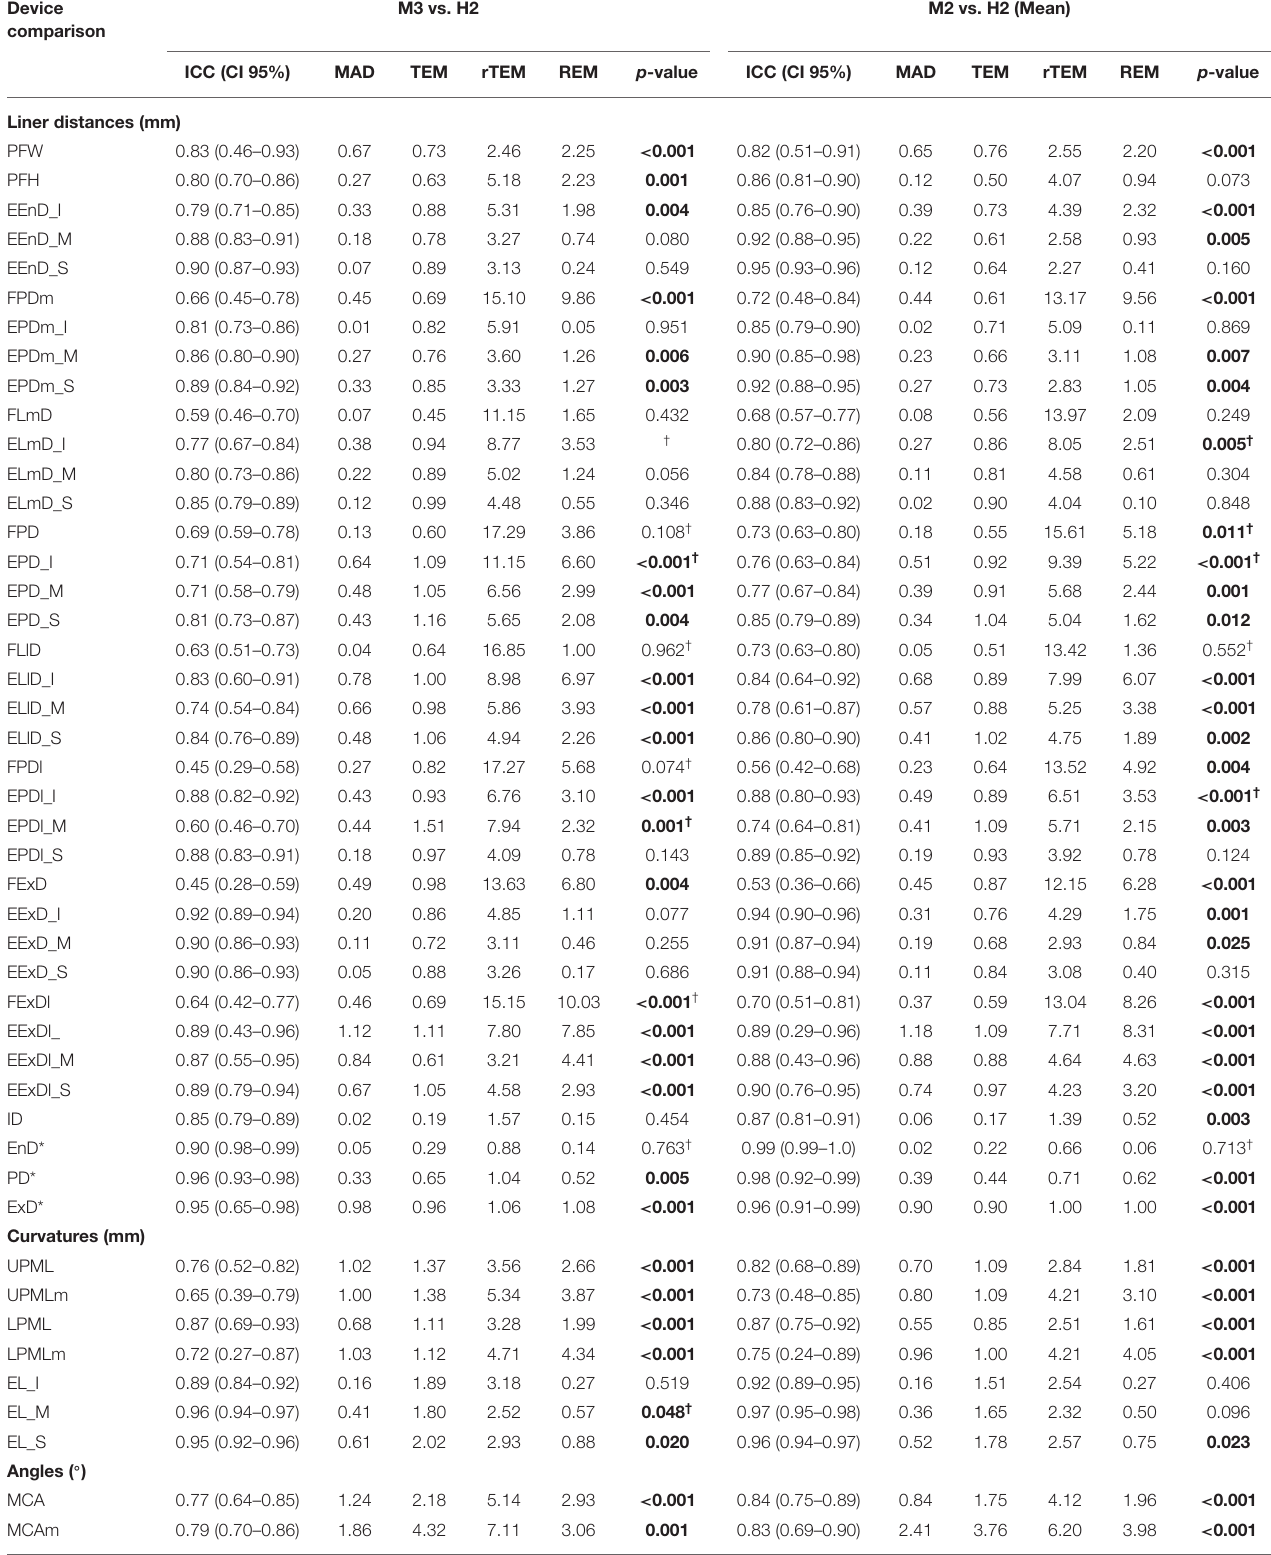
TABLE 5 | Inter-device reliability results of VECTRA M3 and H2 for periocular measurements. Device